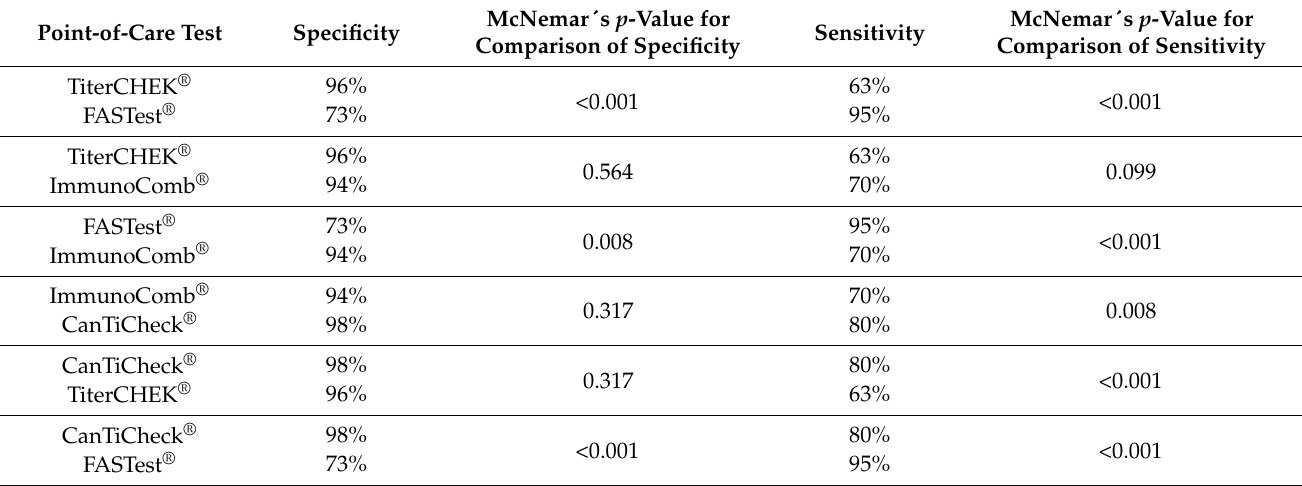
Table 5. Results of McNemar ´ s statistic to determine differences between specificity and sensitivity of the binary point-of- care tests in all dogs.